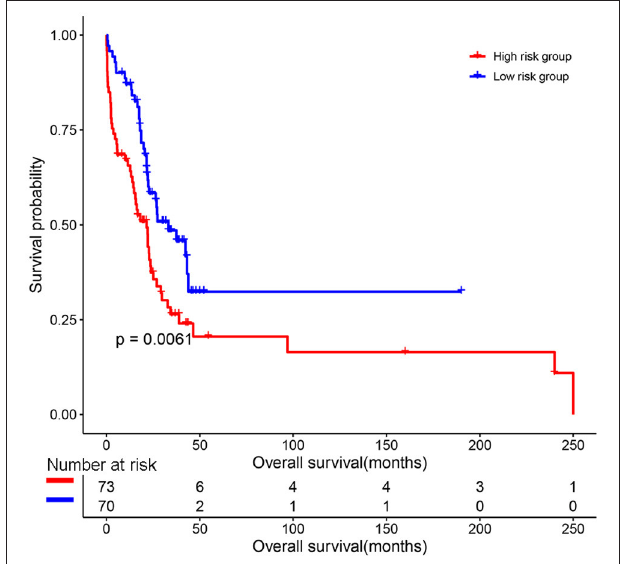
FIGURE 4 | The prognostic role of the 9-gene signature in the independent validation cohort